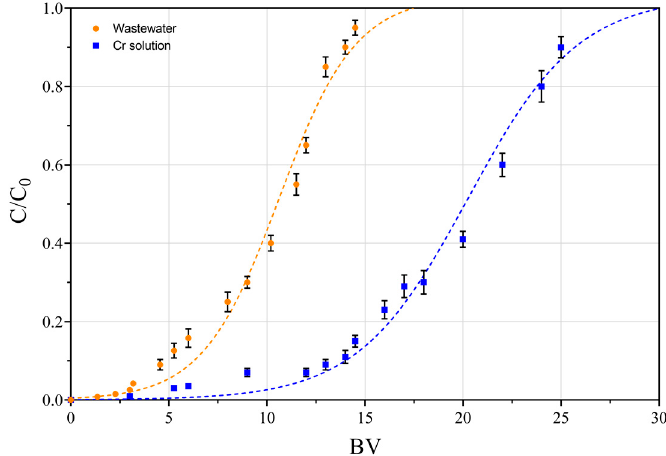
Figure 5. Breakthrough tests performed with real wastewater solution (pH = 3.2) and 500 mg L − 1 chromium(III) solution (at pH = 3.5), using a flow rate of 1 BV h − 1 (BV = 23.6 mL).